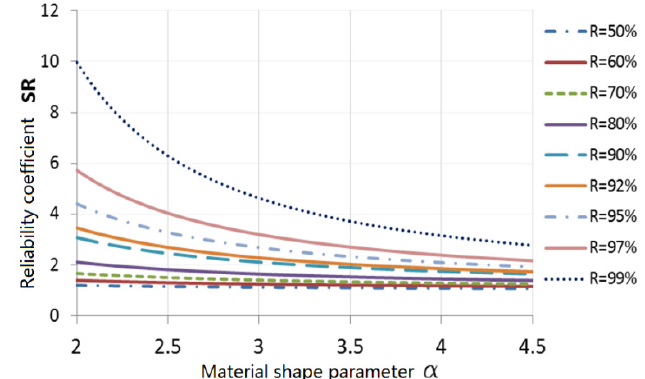
Figure 10. Reliability factors of different reliability levels and material shape parameter.